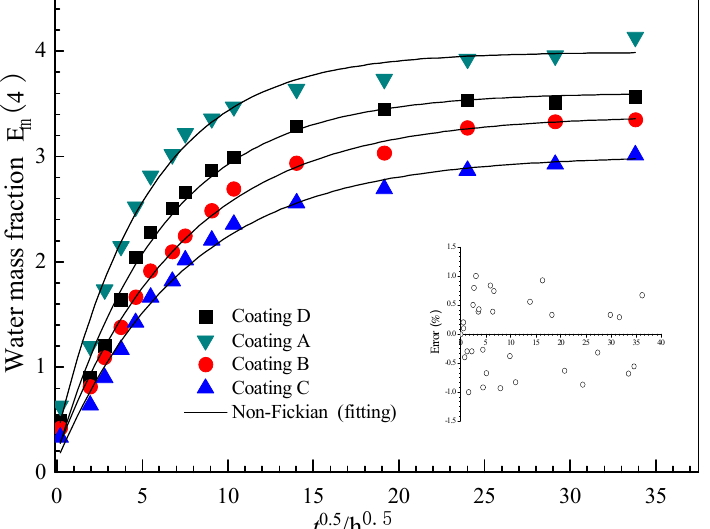
Figure 3. A comparison of the water uptake for the coatings aged in a 5 wt.% NaCl solution obtained via gravimetry.